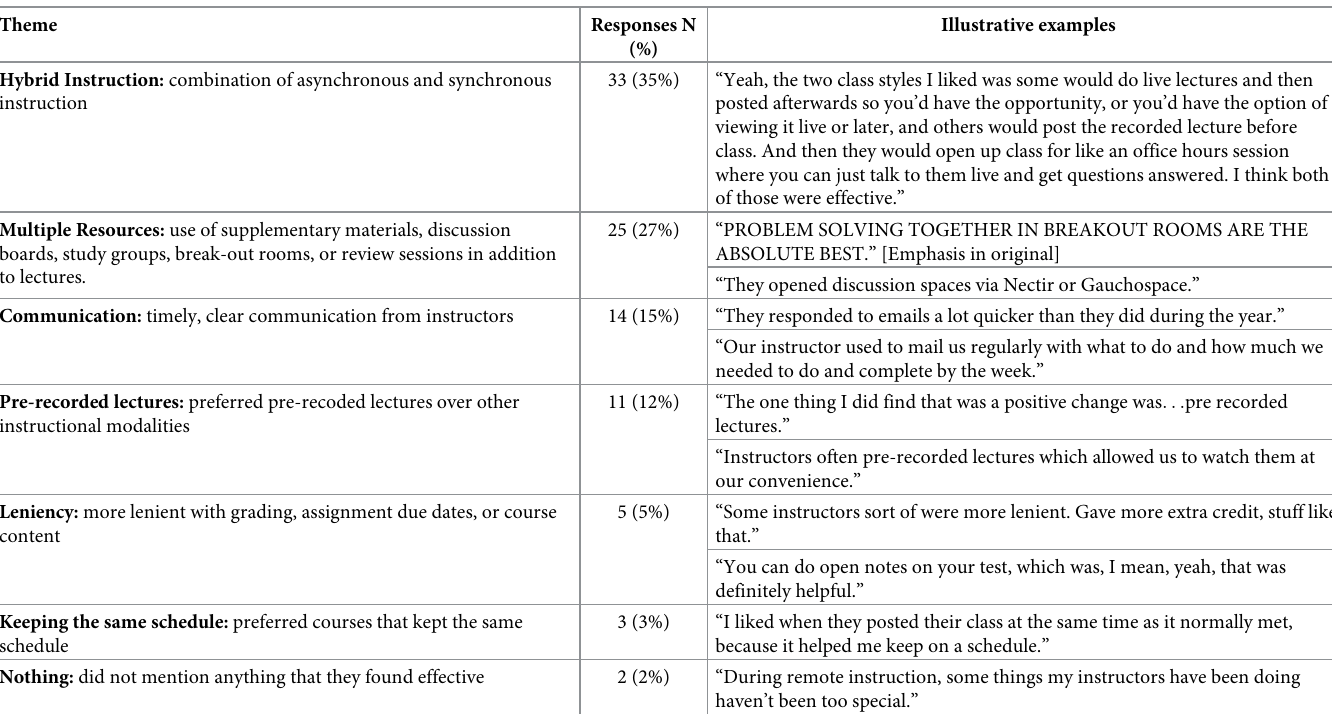
Table 3. Effective instructor strategies, tools, and technologies (N = 59 participants; N = 93